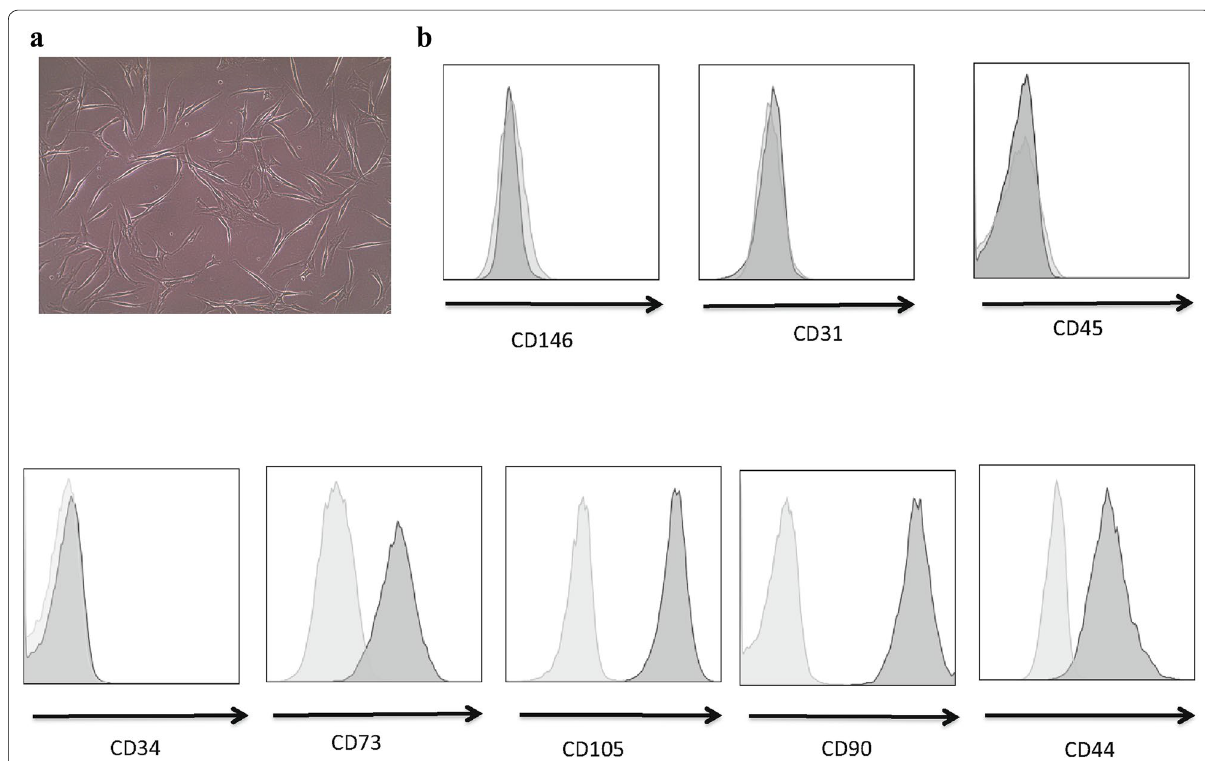
Fig. 4 In vitro culture of adipose tissue-derived cells and their flow cytometry analysis. a The image of adipose tissue-derived cells in culture show- ing fibroblast-like morphology following their adherence to the plastic (Passage 0), X10 magnification. b Representative histograms show adipose- derived and expanded-mesenchymal stem cells are a homogeneous population of cells and express standard ADE-MSCs specific surface markers, including CD73, CD105, CD90, and CD44, and are negative for CD146, CD31, CD45 and CD34 (dark gray filled). Light gray filled lines represent unstained